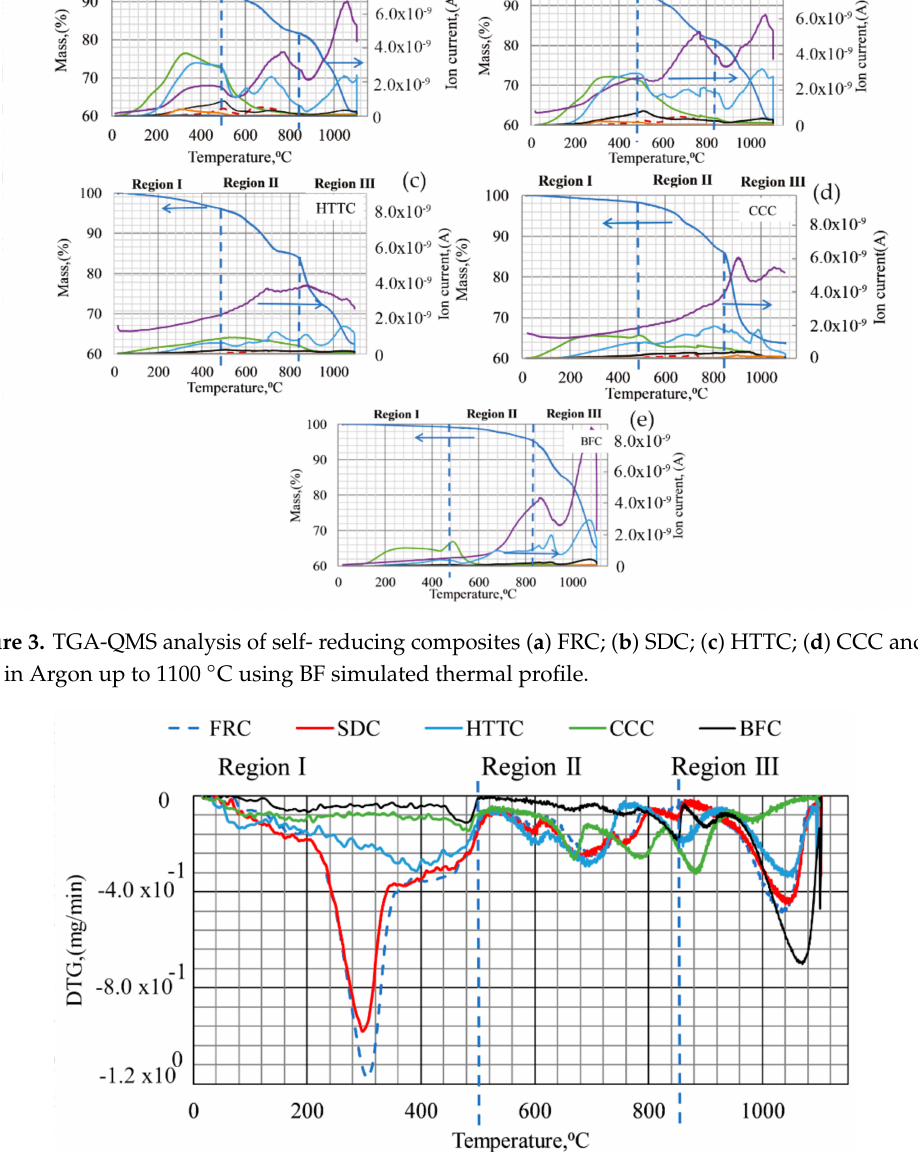
Figure 4. DTG curves of self- reducing composites during TGA tests in Ar gas up to 1100 ◦ C using simulated BF thermal